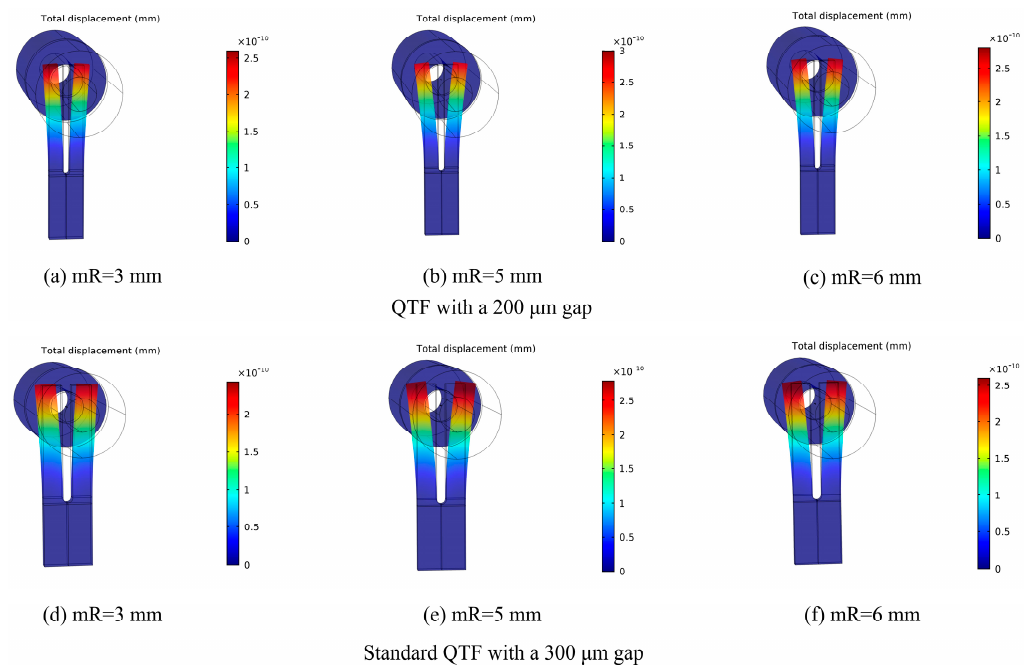
Figure 9. Calculated displacement for two different QTFs with various lengths of micro-resonators (mRs): ( a – c ) for the QTF with a 200 μ m gap; ( d – f ) for the standard QTF with a 300 μ m gap. Table 2. Dimensions and parameters of two QTFs.